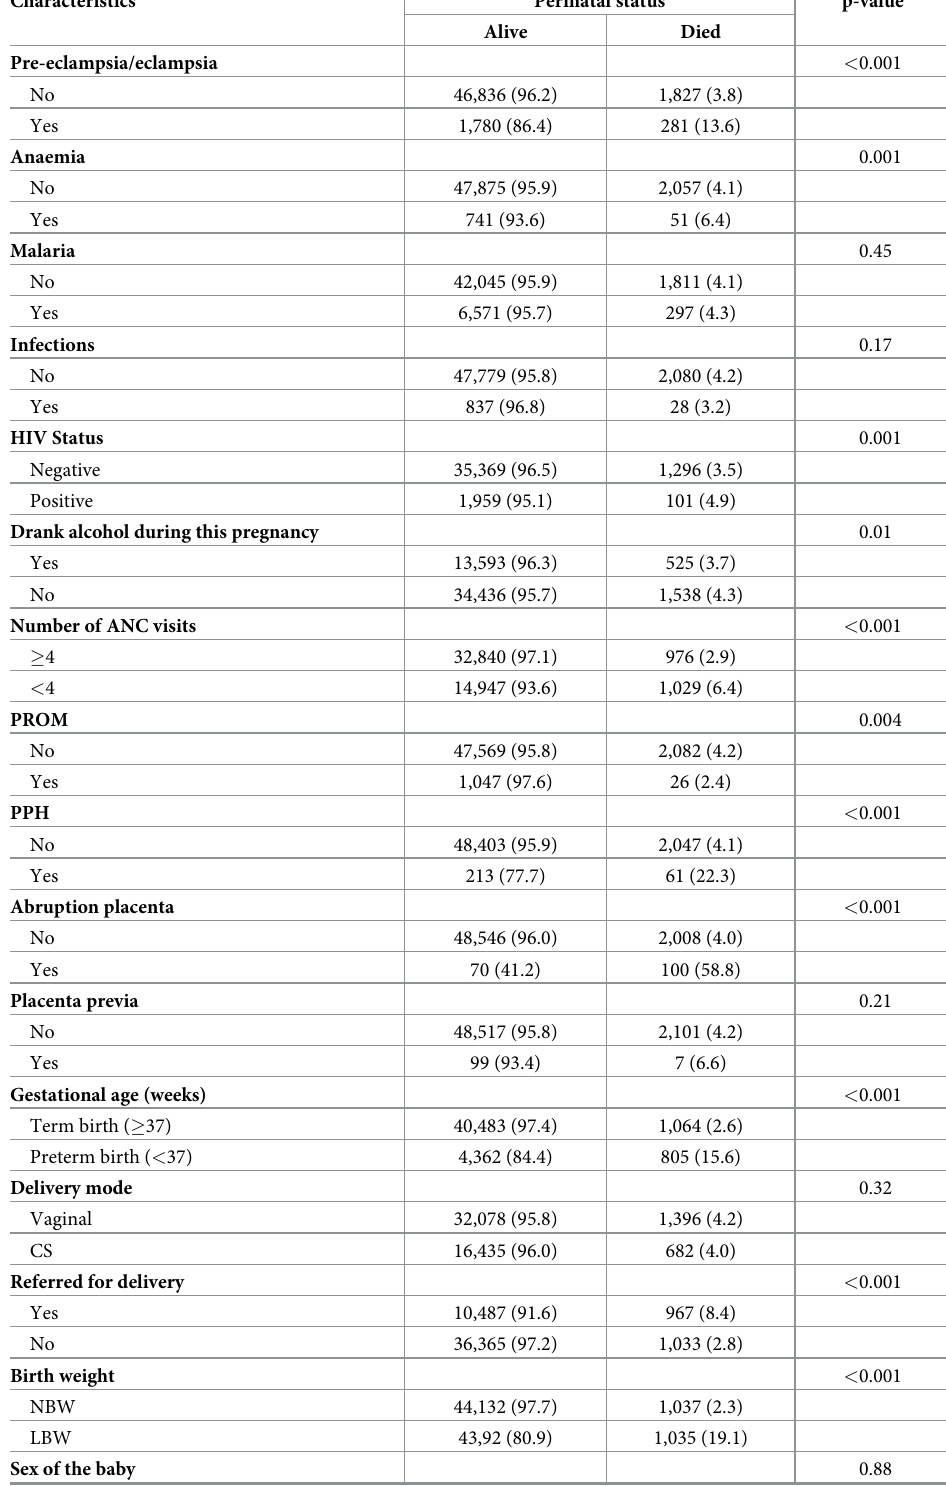
Table 4. Perinatal status by maternal characteristics during pregnancy and delivery (N =